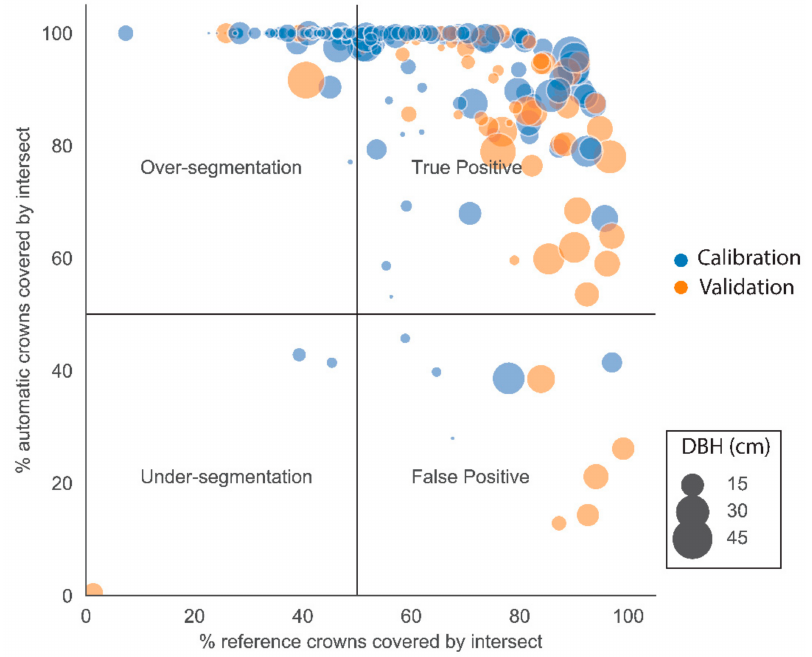
Figure 5. Scatter plot showing the percentage of intersection between manually and automatically delineated crowns. Point sizes are proportional to field measured DBH. Note that when more than one automatically segmented crown overlapped with a manually delineated crown, the automatic crown with the largest percentage cover was used in the